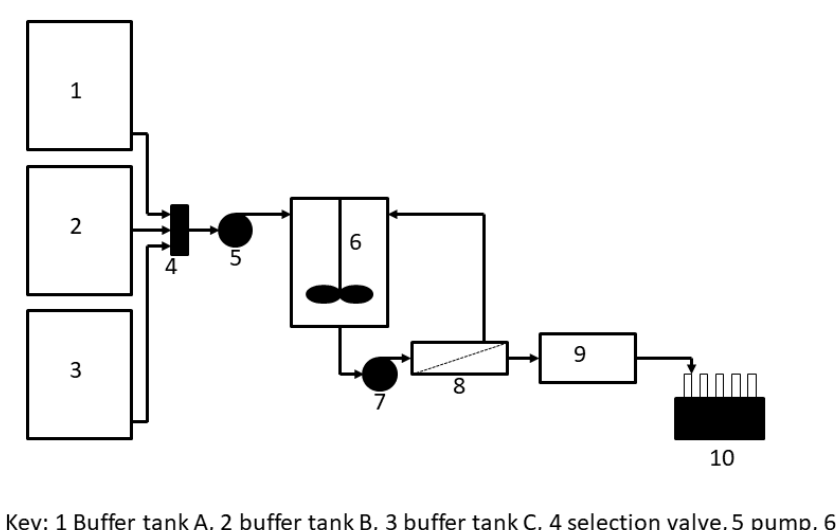
Figure 3. Set-up used for tangential flow-filtration-based hybrid separation of PEGylated protein.